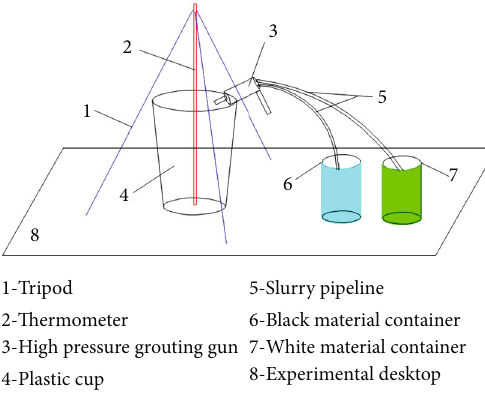
Figure 4: The experimental